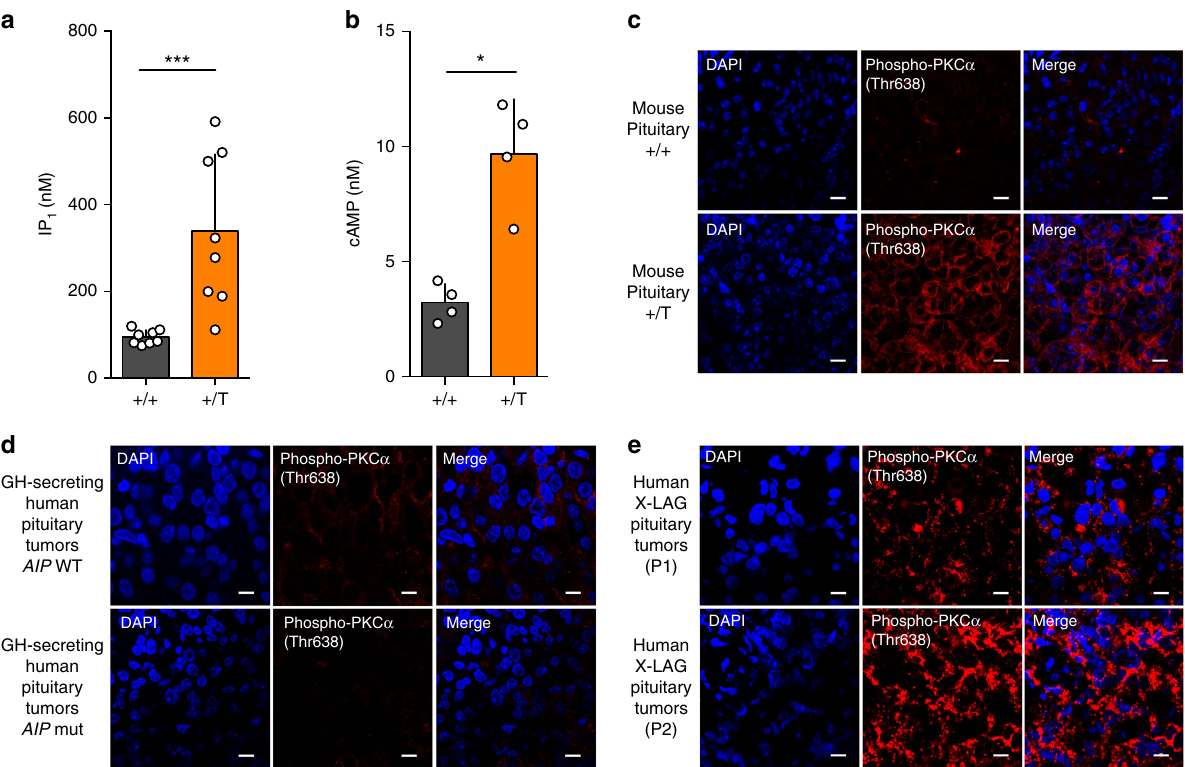
Fig. 7 PKC activation is a signature in somatotropes with high GPR101 expression in vivo. a Quanti fi cation of IP 1 levels in WT ( + / + ) and Ghrhr Gpr101 ( + /T) pituitaries by ELISA in mice aged 29 weeks ( n = 8 mice per group, p = 0.0005). b Quanti fi cation of cAMP levels in WT ( + / + ) and Ghrhr Gpr101 ( + /T) pituitaries by ELISA in mice aged 29 weeks ( n = 4 mice per group, p = 0.0286). c Immuno fl uorescent staining of Phospho-PKC α (Thr638) (in red) and DAPI (in blue) in pituitaries from 29-week-old WT ( + / + ) and WT ( + / + ) mice ( n = 4 mice/group). The results show that the staining for Phospho- PKC α (Thr638) is increased in tg Ghrhr Gpr101 mice compared to WT mice. Scale bar: 10 µ m. d , e Illustrative examples of immuno fl uorescent staining of Phospho-PKC α (Thr638) (in red) and DAPI (in blue) in human GH-secreting pituitary adenomas ( d , in total n = 9 patients) that are either AIP WT (upper panel, n = 6) or AIP mutated (lower panel, n = 3) and illustrative examples of human X-LAG pituitary tumors from two different patients ( e , n = 3 patients). The results show that Phospho-PKC (Thr638) staining in human X-LAG pituitary tumors is elevated. Photos were taken at ×60 magni fi cation. Scale bar: 10 µ m. All data are Mean± S.D. For statistical analysis of all data, a two-sided Mann – Whitney test was used. * p < 0.05; ** p < 0.01; *** p <